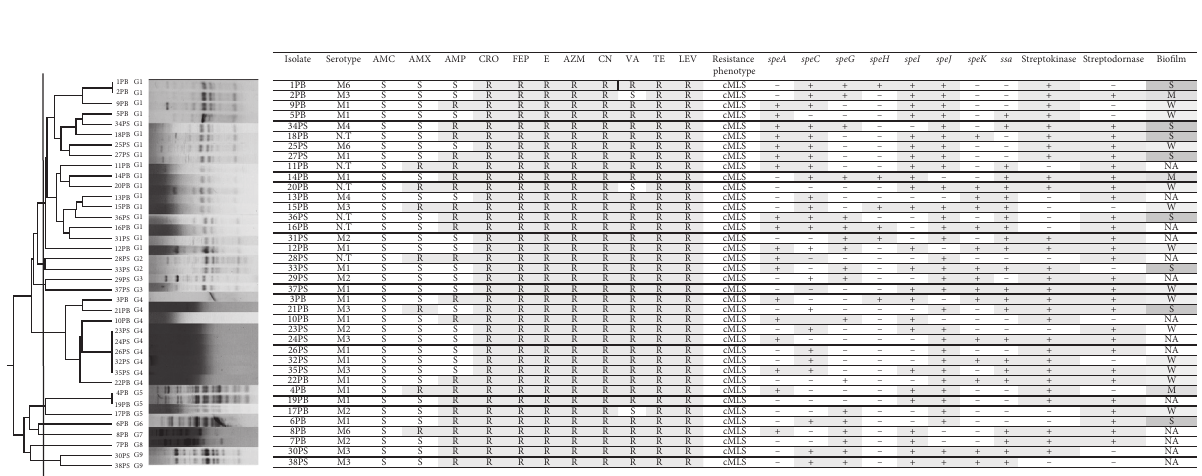
Figure 5: Dendrogram of S. pyogenes BOX-PCR results showing the clustering of isolates into 9 different groups, illustrating different serotypes, SAgsgenes, sensitivity patterns, and some virulence